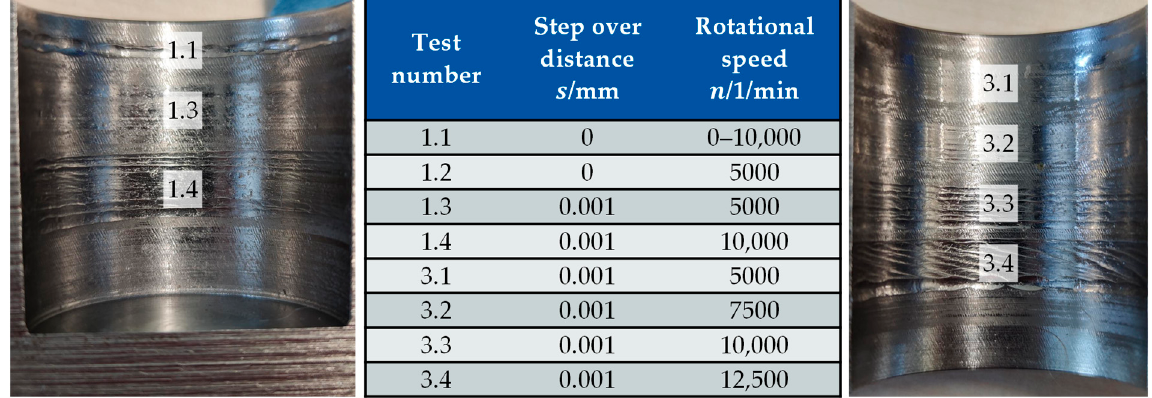
Figure 4. Separated specimen after machining.